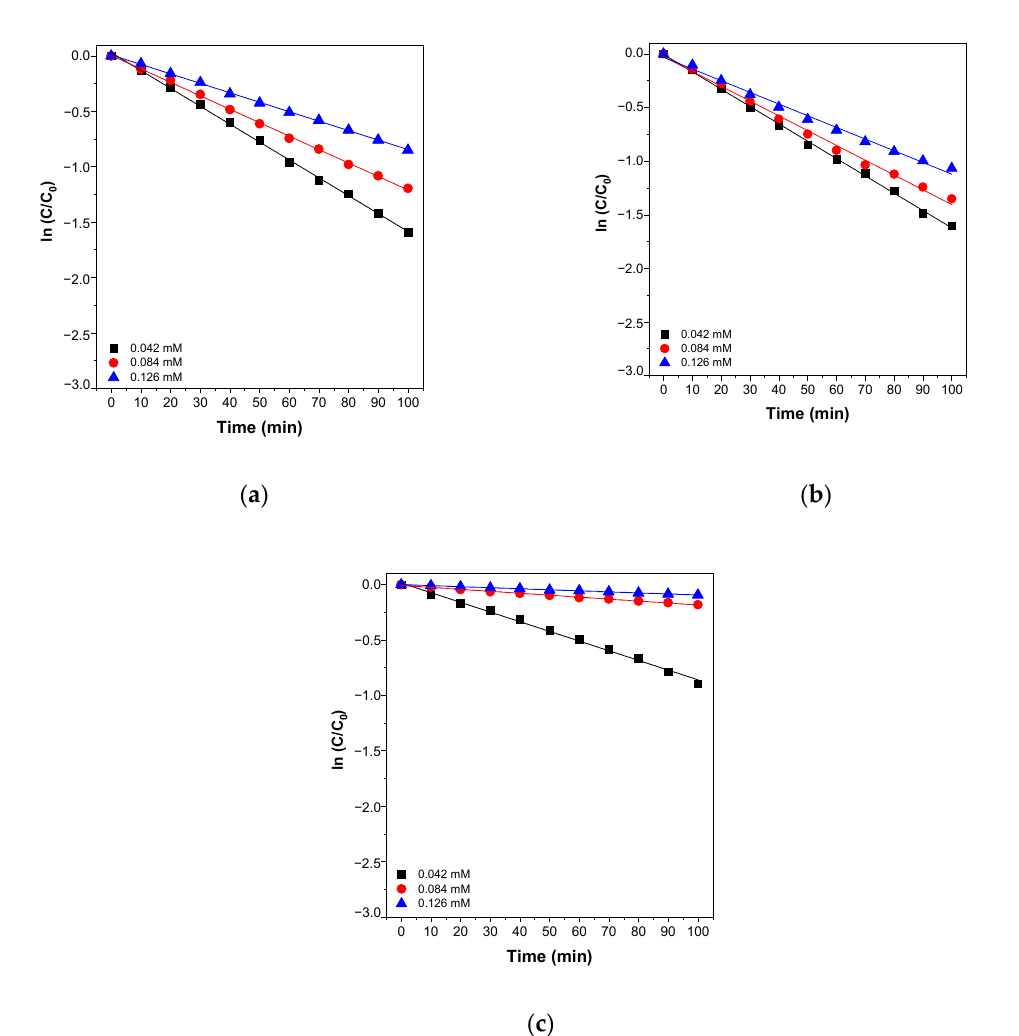
Figure 11. Effect of initial dye concentration on the photocatalytic degradation of the azo dyes: ( a ) MO, ( b ) AO7, and